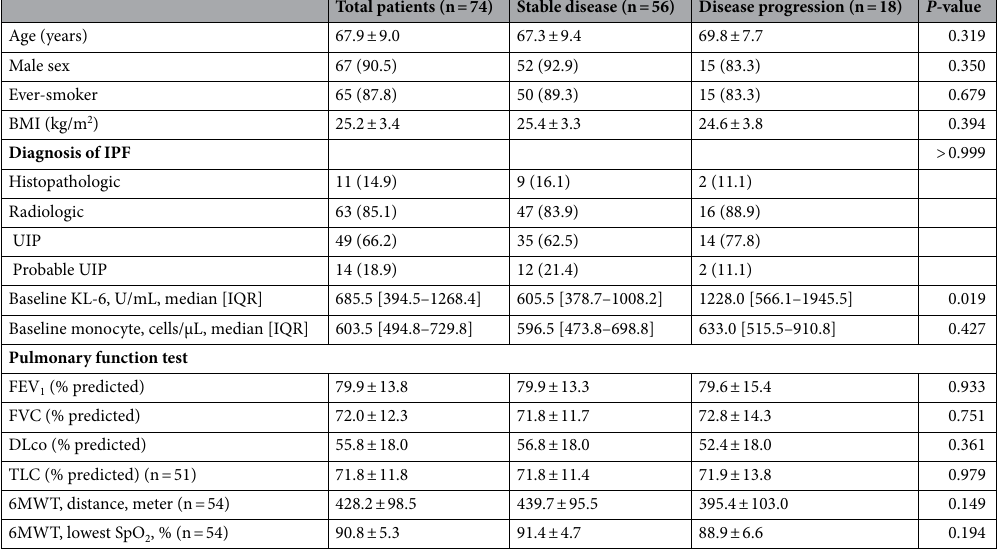
Table 1. Comparison of baseline characteristics in the stable disease vs. disease progression group. Data are presented as the mean ± standard deviation or number (%), unless otherwise indicated. BMI: Body mass index, IPF: Idiopathic pulmonary fibrosis, UIP: Usual interstitial pneumonia, KL-6: Krebs von den Lungen-6, IQR: Interquartile range, FEV 1 : Forced expiratory volume at 1 s, FVC: Forced vital capacity, DLco: Diffusing capacity of the lung for carbon monoxide, TLC: Total lung capacity, 6MWT: 6-min walk test, SpO 2 : Saturation of percutaneous